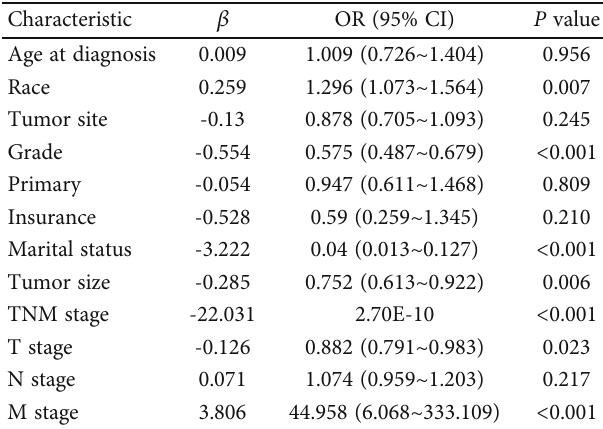
Table 3: Logistic regression analysis of multivariate factor a ff ecting gastric cancer bone metastasis.